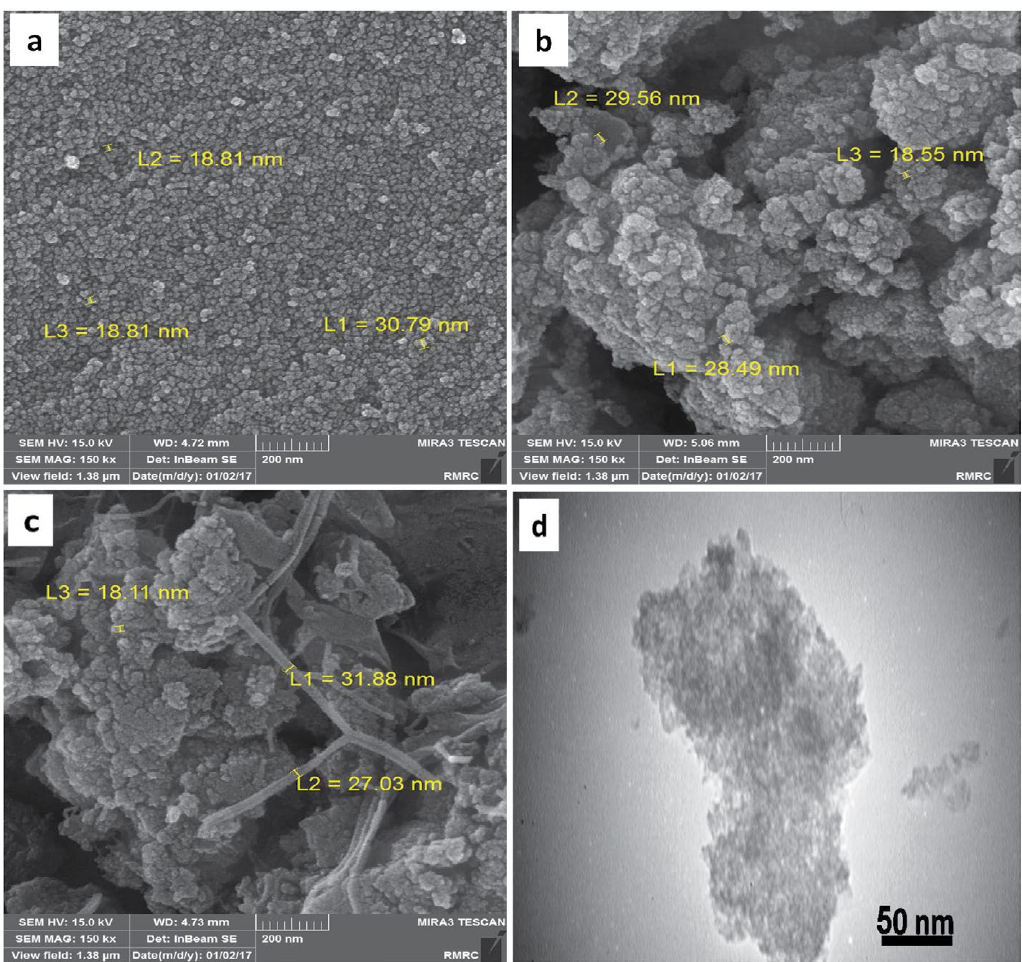
Fig. 2. FESEM images of samples. (a) TiO